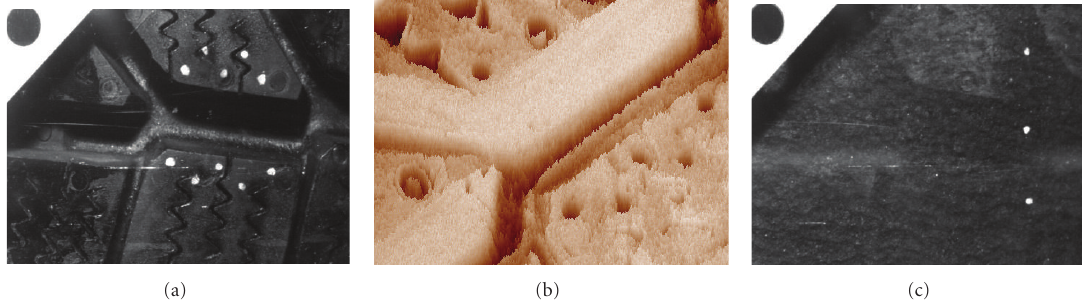
Figure 13: Tire surfaces under tests: (a) observed points on tread elements; (b) 3D handling and magnification of tread elements; (c) observed points on slick tire.